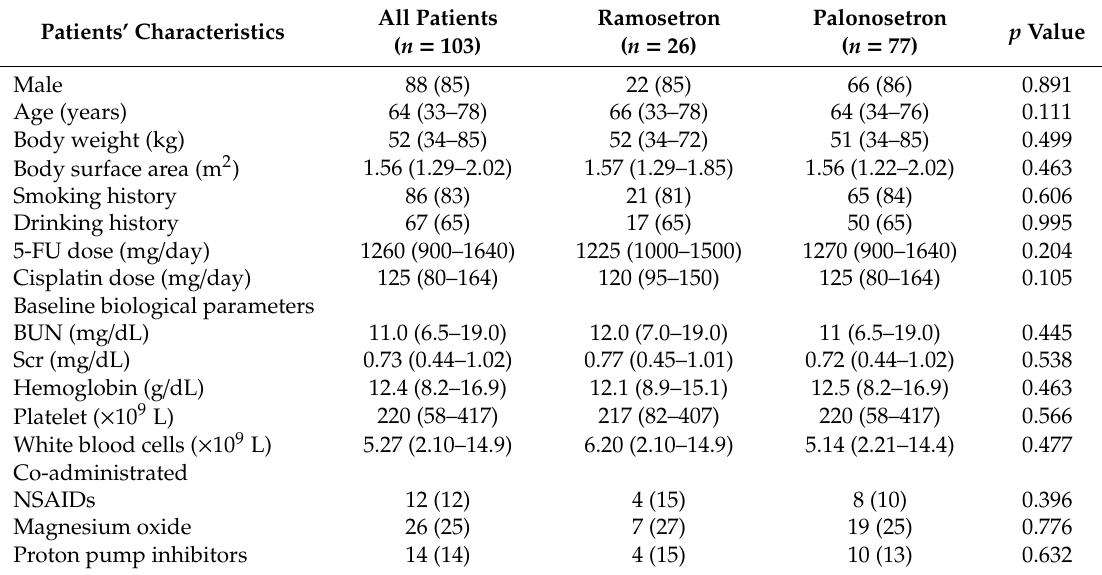
Table 1. Characteristics of patients treated with ramosetron or palonosetron.